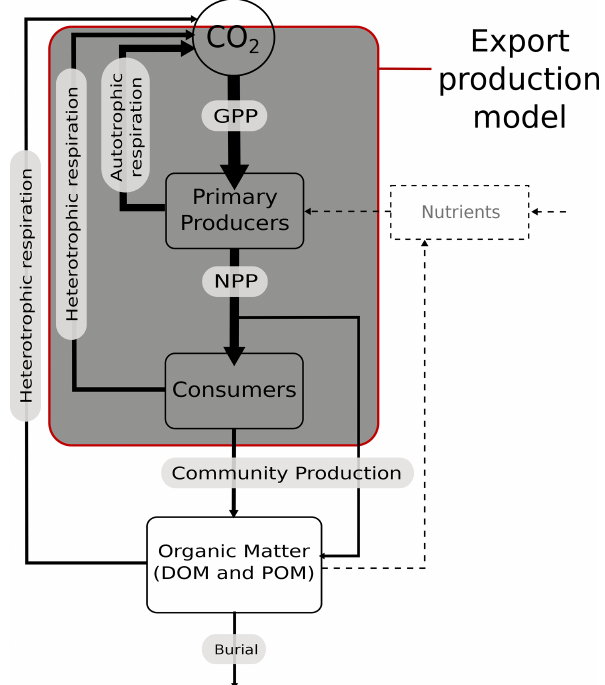
Figure 2. Schematic of biological pump processes showing where cGENIE export production operates. In the export production model, no mechanistic consideration of the effects of temperature within the mixed layer (i.e. GPP vs. NPP vs. community produc- tion) can be considered, but heterotrophic respiration (as reminer- alisation) vs. community production (as export production) can be considered, as can nutrient recycling. In this study we apply temper- ature dependency to organic matter production and remineralisation that drives the biological carbon pump. We do not model burial in this version of cGENIE (but it is here for completeness). In this cGENIE configuration, the nutrient is phosphate. The dashed line indicates the cycling (and resupply due to circulation) of nutrients. Solid lines indicate the cycling of